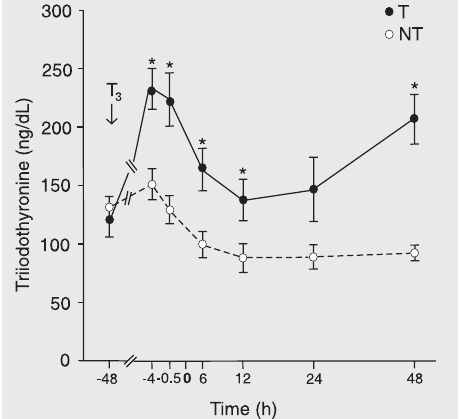
Figure 1. Serum triiodothyronine (T 3 ) in the groups studied. T = T 3 -treated group, N = 8; NT = placebo- treated group, N = 10; -48 = 2 days before cross-clamp removal (baseline); -4 = 1 h before going into surgery and 4 h before cross-clamp removal (24 h after the beginning of T 3 or placebo); -0.5 = within 30 min of cardiopulmonary bypass; 0 = cross-clamp removal; 6 = 6 h after aortic cross-clamp removal; 12 = 12 h after aortic cross-clamp removal; 24 = 24 h after aortic cross- clamp removal; 48 = 48 h after aortic cross-clamp removal. *P < 0.05 compared to control (ANOVA for repeated measures; post hoc Student-Newman-Keuls test).